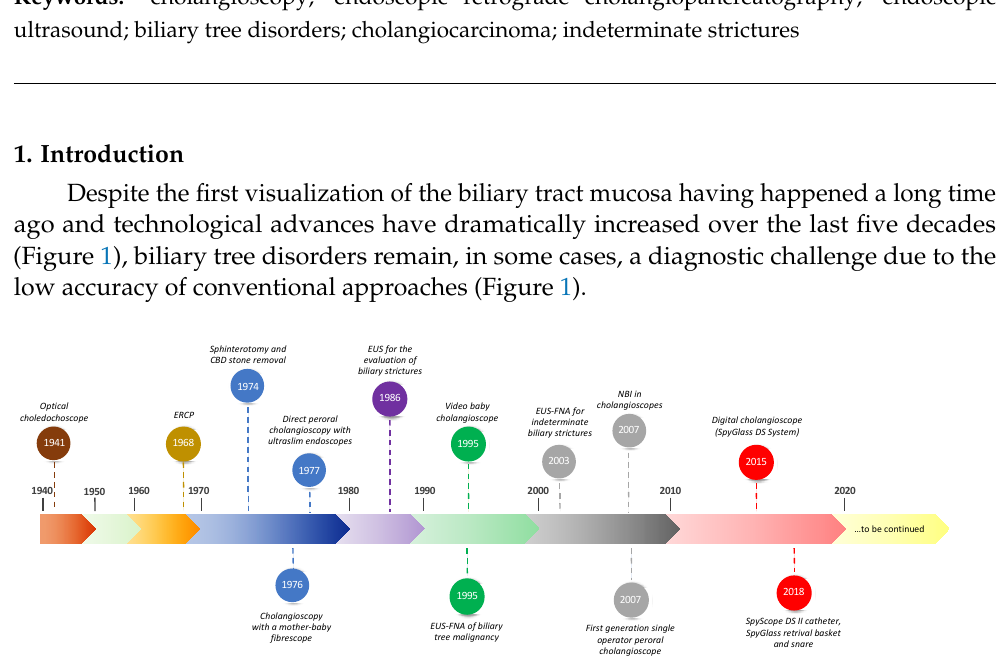
Figure 1. Timeline with the landmark advancements in the assessment of the biliary tree